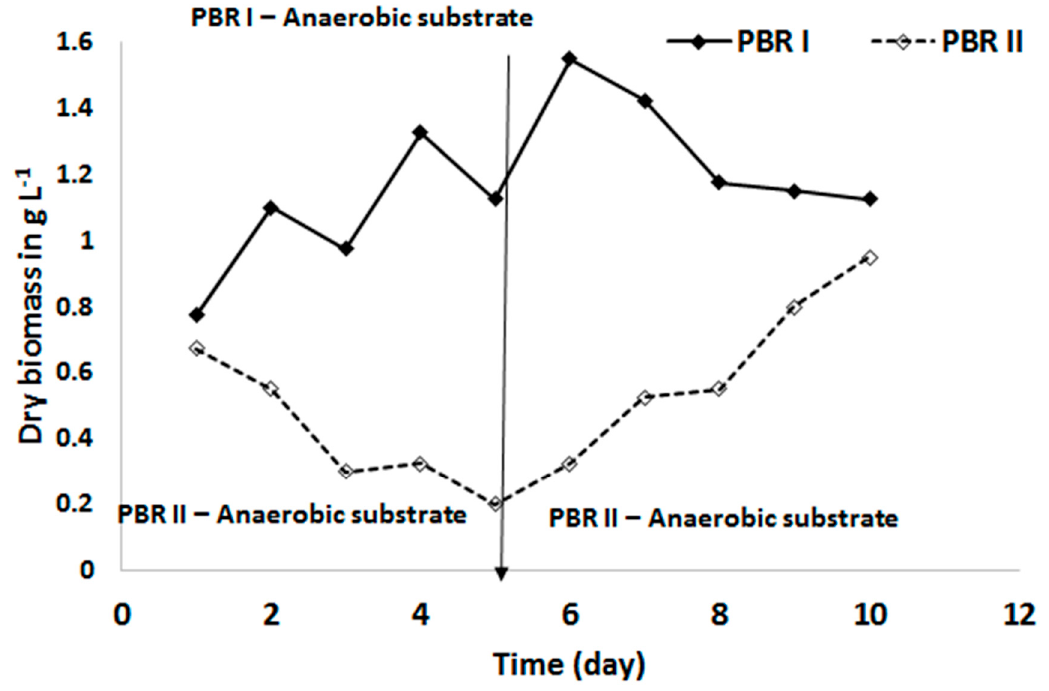
Figure 7. The response of Chlorella sorokiniana to anaerobic substrate condition. Photobioreactor (PBR) I substrate was kept anaerobic during the entire 10 days of the experiment, while in PBR II the substrate was kept aerobic in the first 5 days and anaerobic thereafter.